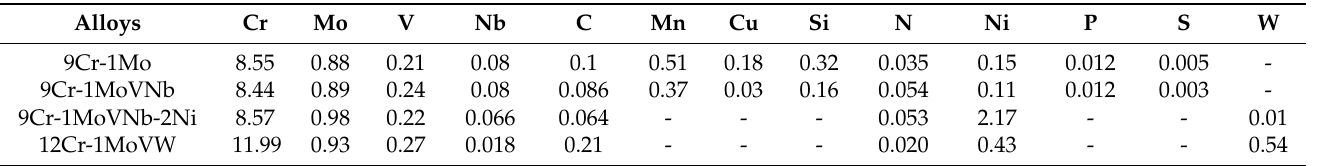
Table 5. Elemental composition of some martensitic alloys, reprinted with permission from refs. [43–45]. Copyright 2020 International Atomic Energy Agency (IAEA).